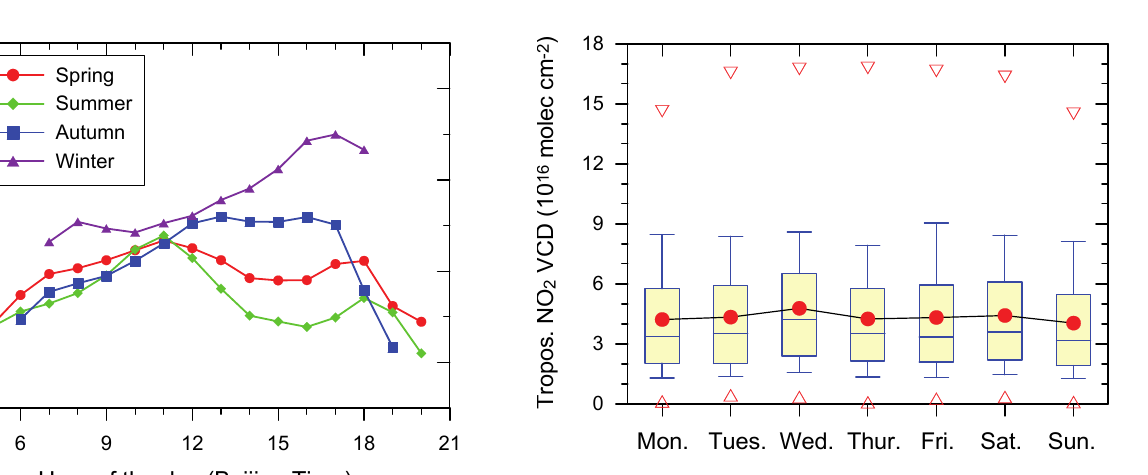
Apparently, the tropospheric NO 2 VCD over Beijing was the lowest on Sunday late afternoon (4.3 × 10 16 molecules cm − 2 at 17:00 BJT).